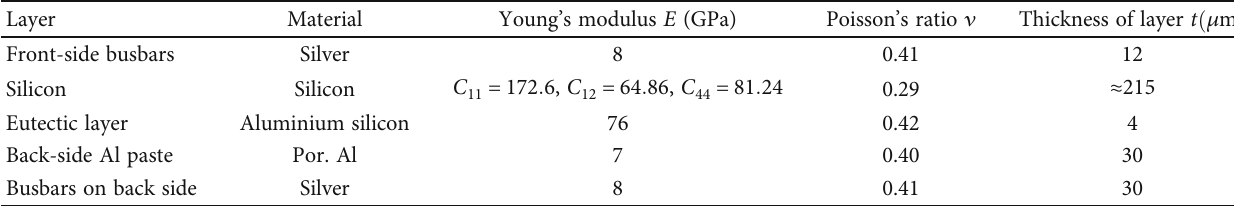
Table 1: The mechanical model ’ s material parameters.